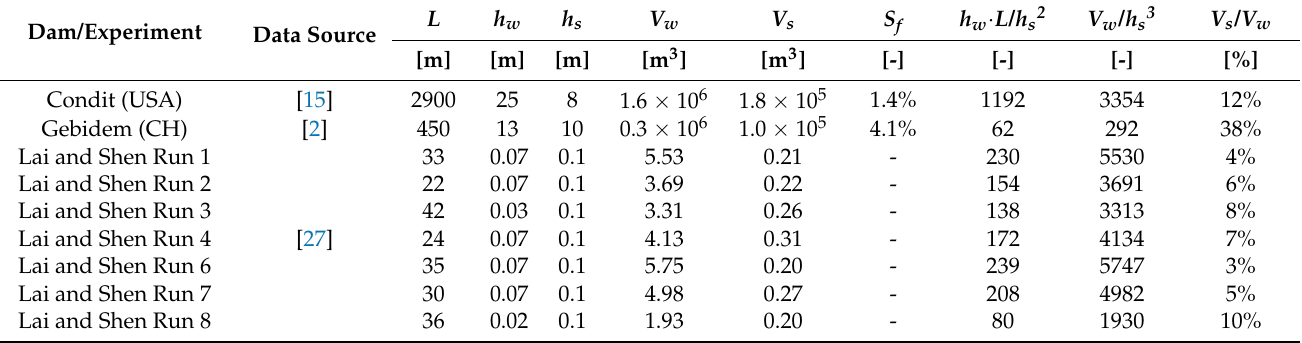
Table 2. Values for the variables and parameters obtained from previous studies for